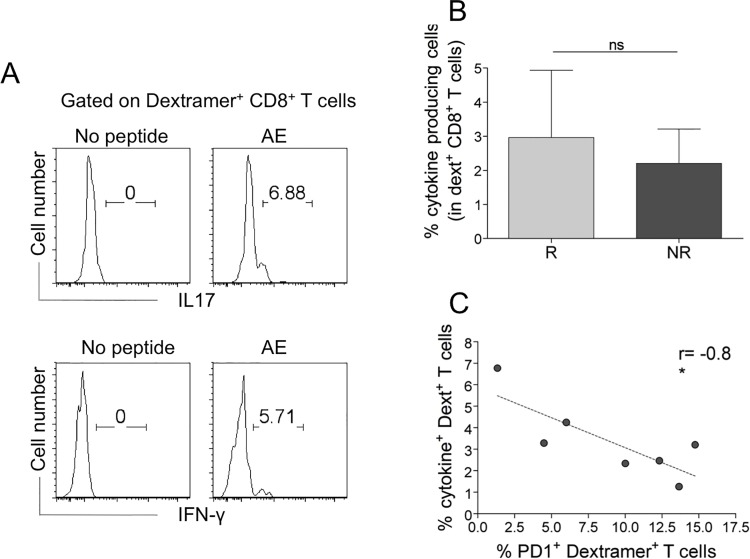
AE-specific dextramer+CD8+ T cells specifically producing inflammatory cytokines inversely correlate with PD-1+dextramer+CD8+ T cells (A-C).(A) Representative flow cytometry analyses of cells producing IL-17 or IFN-γ in dextramer+CD8+ T cells in response to a relevant AE pool (5 peptides). (B) Percentage of cytokine-producing cells in dextramer+CD8+ T cells from Rs and NRs. Statistical analysis was performed with the Mann-Whitney test. ns = not significant. (C) Correlation between cytokine-producing dextramer+CD8+ T cells and those expressing PD-1 (Spearman correlation analysis). Analyses were performed at time 0 (before the start of therapy).